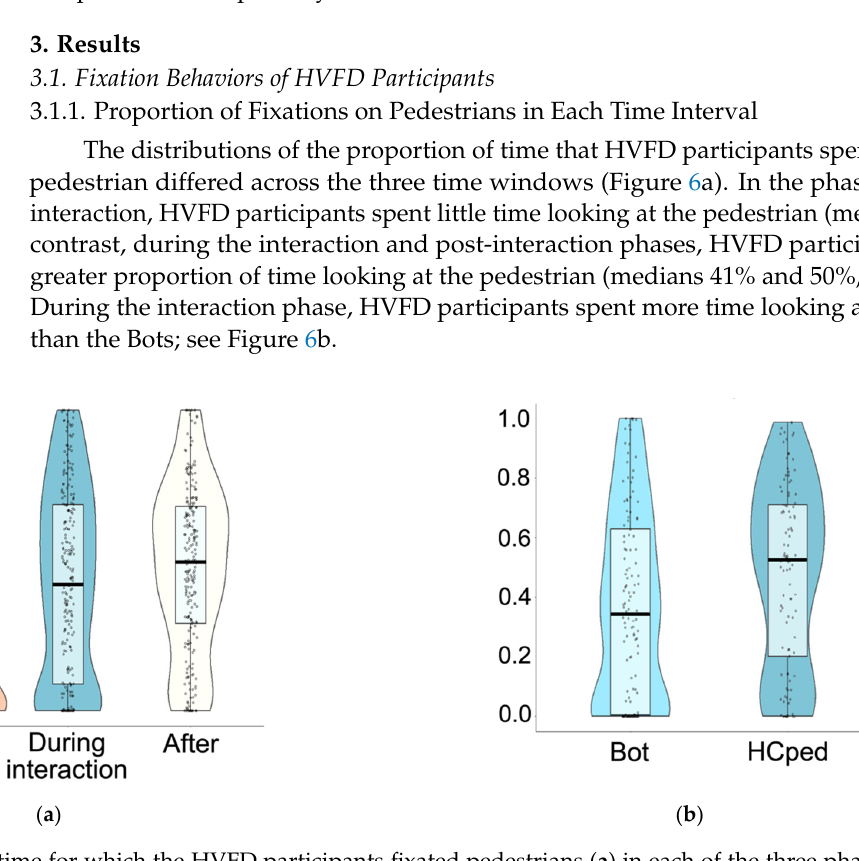
Figure 6. Proportion of time for which the HVFD participants fixated pedestrians ( a ) in each of the three phases of the pedestrian crossing (data pooled across pedestrian type) and ( b ) for the two pedestrian types during the interaction phase.